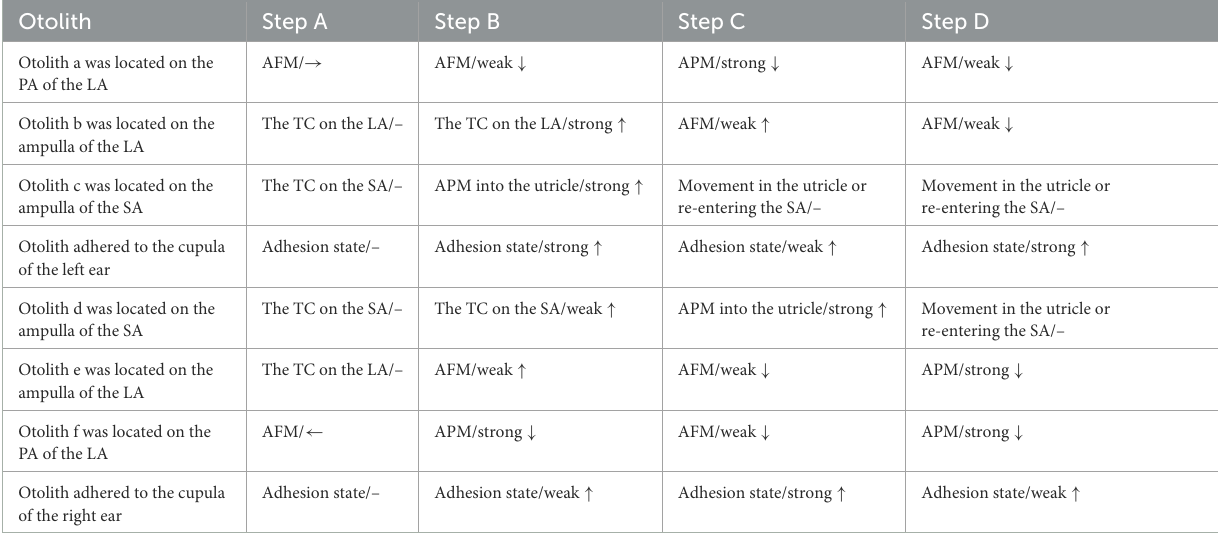
TABLE 2 Otolith motion and nystagmus speculation in the 60 ◦ head roll test.